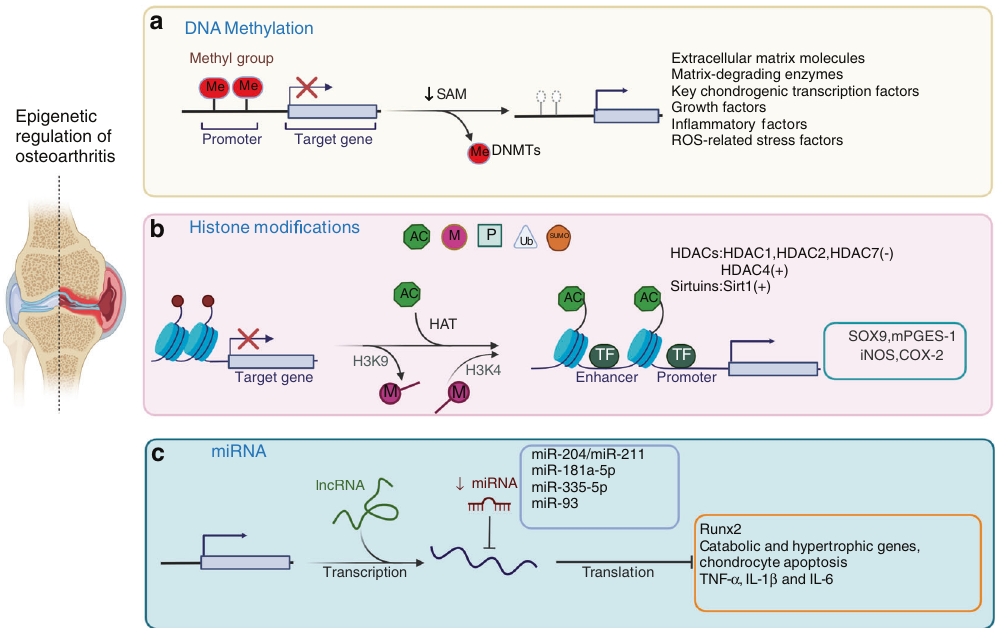
Fig. 1 Epigenetic regulation of osteoarthritis. Three types of epigenetic regulation of the molecular pathogenesis of OA. a DNA methylation is catalyzed by DNMTs, and abnormal changes in DNA methylation occur in the promoter regions of related genes and signaling pathways in OA chondrocytes. b Histone modi fi cations included phosphorylation, methylation, acetylation, ubiquitination, and SUMOylation. Histone acetylation is mainly mediated by HATs, and histone deacetylation is usually catalyzed by two types of enzymes: classic histone deacetylases (HDACs) and sirtuins. Increased H3K4 methylation leads to catabolic responses mediated by iNOS and COX-2 expression in human OA chondrocytes. The methylation of H3K9 increases Sox9 and mPGES-1 expression in human OA chondrocytes. c MiR-204/miR-211, miR-181a-5p, miR-335-5p, and miR-93 inhibit Runx2, chondrocyte apoptosis, and the expression of catabolic and hypertrophic